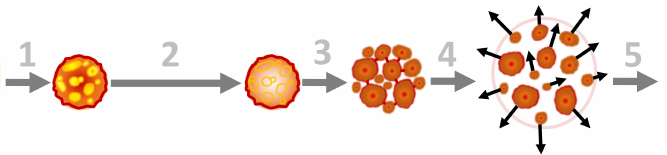
Figure A4. Schema of multi-fragmentation of giant nuclei. Transition “1”: disruption of a compact super-dense stellar-object (left) leading to “birth” of a stellar-fragment (right). Transition “2”: cooling of the “hot” (left) stellar-fragment leading to “cooler” quasi-stable state (right). Transition “3”: fluctuation/perturbation of the quasi-stable nuclear matter (left) and initiation of multi-fragmentation once unstable (right). Transition “4”: explosive expansion (once β -decays become no longer Pauli- blocked). Transition “5”: multi-fragmentation and fission of each hyper-nucleus (each droplet of nuclear fog), followed by chains of cascades (multi-fragmentation, fission, neutron-, β -, and γ - emissions; see Figure 1, right panel, and Figure 2) and dispersion of the material. Repetitions of steps 3–4–5 produce nuclei with lower and lower numbers of nucleons A , eventually reaching the valley-of-stability ( A ∼ 10 2 –10 1